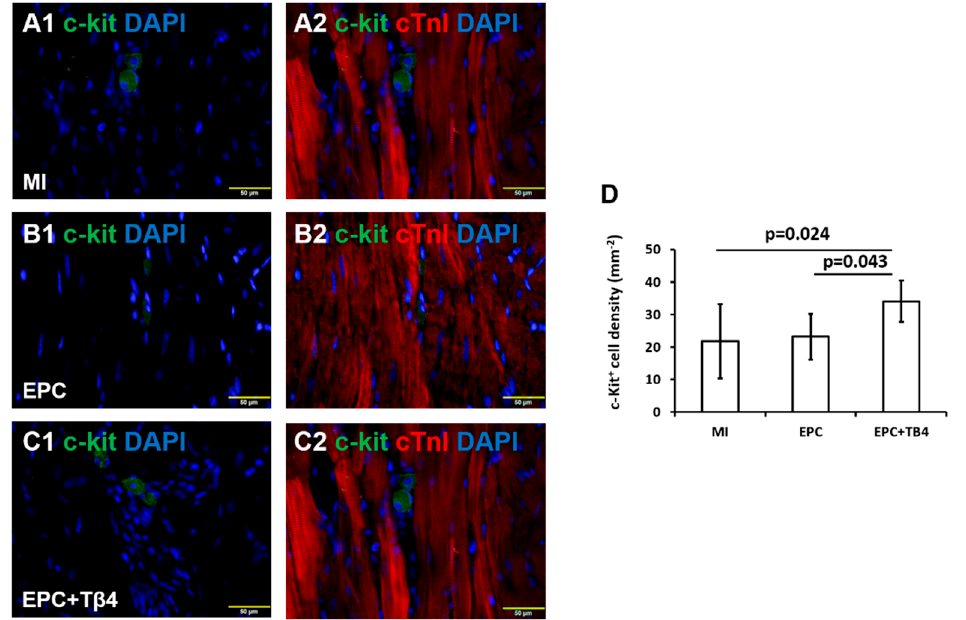
Figure 5. Fluorescence immunostaining for c-Kit ( A1 , B1 , and C1 ) and cardiac troponin I ( A2 , B2 , and C2 ) expressions in hearts of MI, EPC, and EPC + T β 4 rat groups. ( D ) Quantification of c-Kit + cardiac cells in in hearts of MI, EPC, and EPC + T β 4 rat groups. (A–C magnification = 400 × ) ( n = 6 for each group).